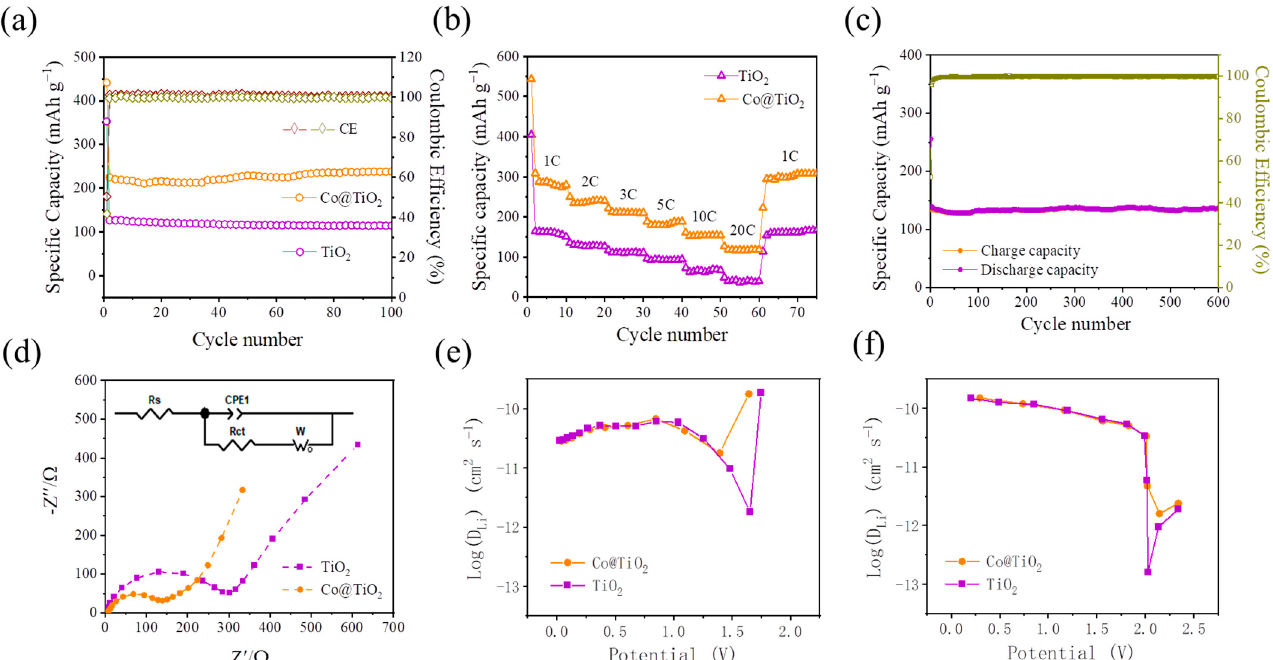
Figure 6. ( a ) Cycling performance over the potential window 0.01–3.0 V at 3 C. ( b ) Rate performance at various current rates of TiO 2 and Co@TiO 2 over the potential window 0.01–3.0 V. ( c ) Cycling performance of the Co@TiO 2 sample over the potential window 0.01–3.0 V at 10 C. ( d ) EIS of the Co@TiO 2 and TiO 2 electrodes. ( e , f ) GITT curves and D Li values of the Co@TiO 2 and TiO 2 electrodes.